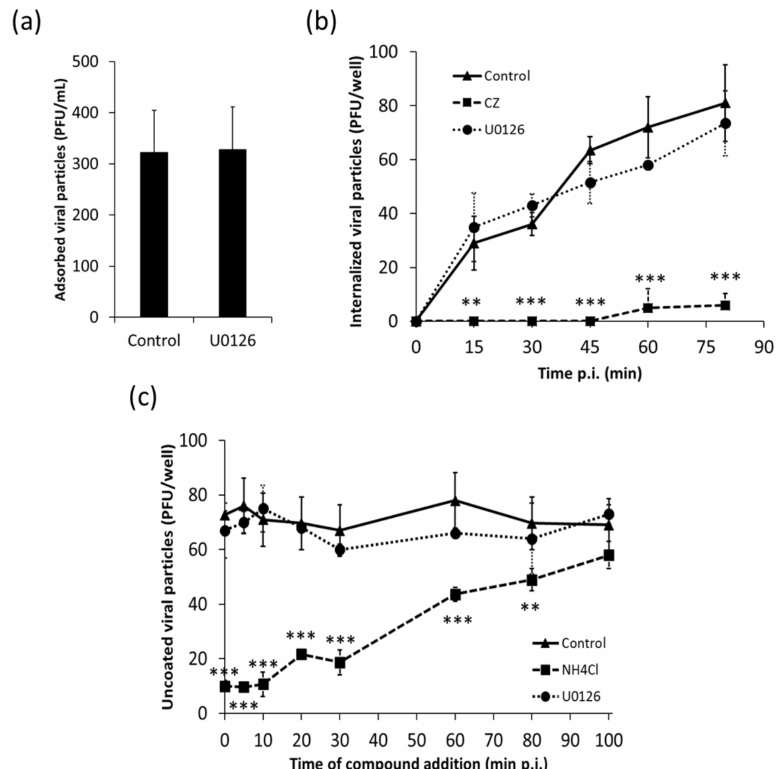
Figure 1. Inhibition of the ERK1/2 pathway does not affect Jun í n virus (JUNV) entry or uncoating. ( a ) Vero cells were mock-treated or treated with U0126 (15 µ M) for 1 h, and then cells were infected with JUNV (m.o.i. = 1) in presence or absence of U0126 for 1 h at 4 ◦ C. Following extensive washing, cells were lysed and viral infectivity was quantified by plaque assay. Data are mean values ± standard deviation (SD); ( b ) Vero cells were mock-treated or treated with U0126 (15 µ M) or CZ (40 µ M) for 30 min and then infected with JUNV for 1 h at 4 ◦ C. Next, cultures were incubated at 37 ◦ C in the presence or absence of the inhibitors. At different time points, internalized virions were quantified by plaque assay. Data are mean values ± SD. ANOVA (Tukey post-hoc test): ** p < 0.01, *** p < 0.001; ( c ) Vero cells infected with JUNV for 1 h at 4 ◦ C were incubated at 37 ◦ C and at the indicated time points U0126 (15 µ M) or NH 4 Cl (50 mM) was added. After 3 h of treatment, uncoated viral particles were quantified by plaque assay. Data are mean values ± SD. ANOVA (Tukey post-hoc test): ** p < 0.01, *** p <